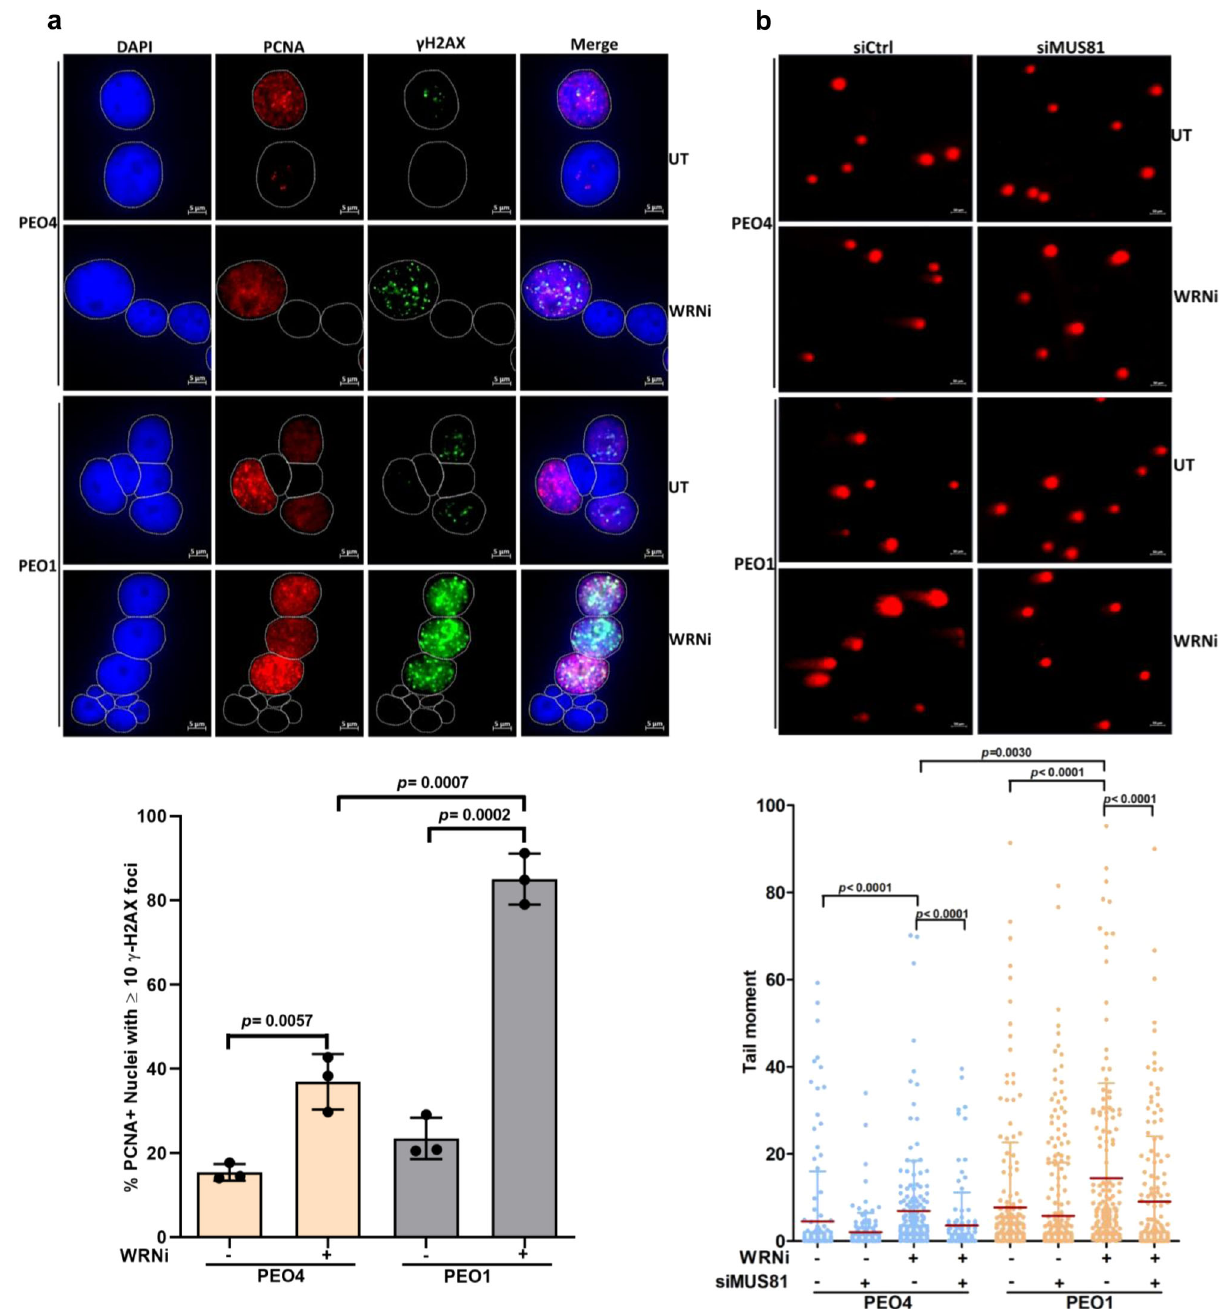
Fig. 6 WRNi triggers MUS81-dependent double-strand break formation in BRCA2 -mutated cancer cells. a Immuno fl uorescence staining of γ H2AX following treatment of PEO4 and PEO1 cells with WRNi (5 µ M) for 6 h. Cells were co-stained with PCNA to identify replicating cells. Nuclei were stained with DAPI. DAPI, PCNA, and γ H2AX are shown in blue, red, and green, respectively. Scale bars are shown. Bar graph represents quanti fi cation of % PCNA- positive cells with ≥ 10 γ H2AX foci under untreated (UT) and WRNi-treated conditions. Data represent mean ± SD of three independent experiments; two- tailed unpaired t -test; p values are indicated. b Analysis of DSB formation using neutral Comet assay. Control or MUS81-depleted PEO4 and PEO1 cells were subjected to neutral comet assay following treatment with WRNi (5 µ M) for 6 h. Representative images of comets obtained from individual experimental conditions are shown. Scale bars are shown. Scatter dot plot showing tail moment in individual samples. Data represent mean ± SD of n ≥ 120 comets analyzed under each condition over n = 2 independent experiments. Mean tail moments (horizontal red bars) ± SD are shown. ≥ 120 comets were analyzed for each condition using the OpenComet plugin in ImageJ. Two-tailed Mann – Whitney test; p values ( p < 0.0001 , p < 0.0001 , p = 0.0030, p < 0.0001, p < 0.0001) are indicated. Source data are provided as a Source Data fi WRN − / − U2OS cells exposed to NSC617145 (Supplementary signi fi cantly rescued in WRN-depleted HeLa and DLD1 cells Fig. 13c, d) further attested to the speci fi city of the compound. (Supplementary Fig. 13a, b), suggesting WRN-dependent cyto- However, isogenic RECQL1 -de fi cient and RECQL1- corrected cells toxicity of the inhibitor. Substantially improved survival of exhibited similar sensitivity to the WRNi (Supplementary